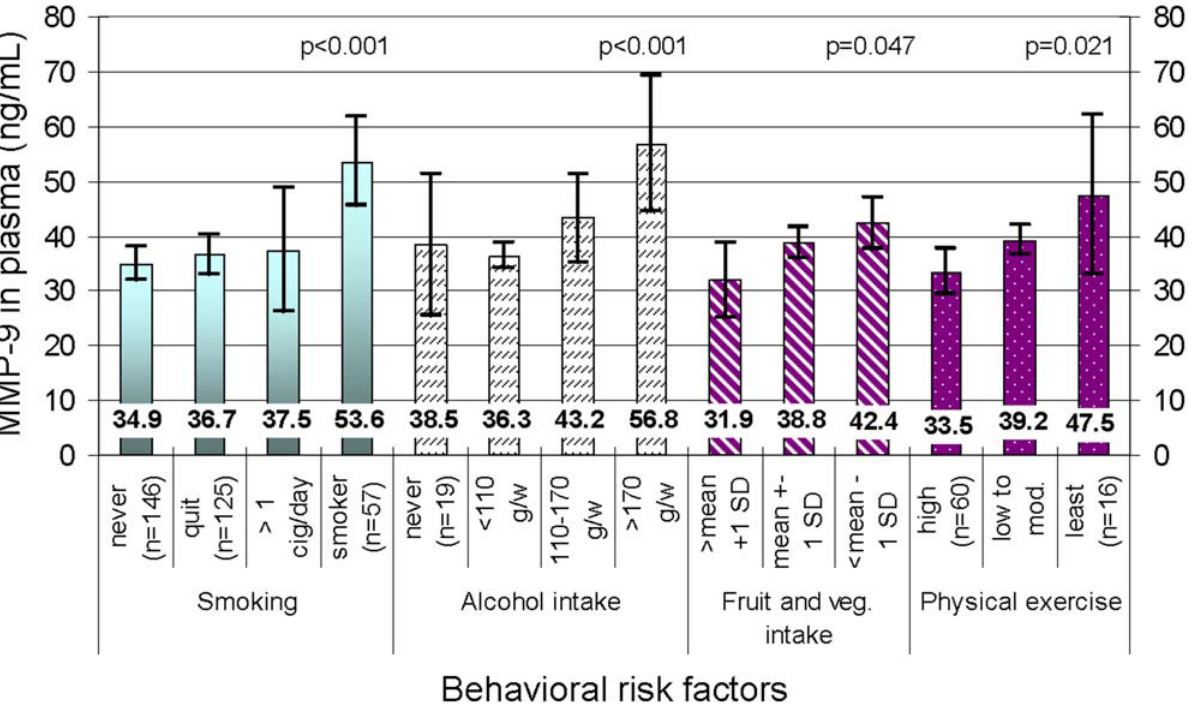
Figure 2. MMP-9 in relation to ordinal categories of smoking, alcohol intake, fruit and vegetable intake and physical exercise, respectively. Mean and 95% confidence intervals.